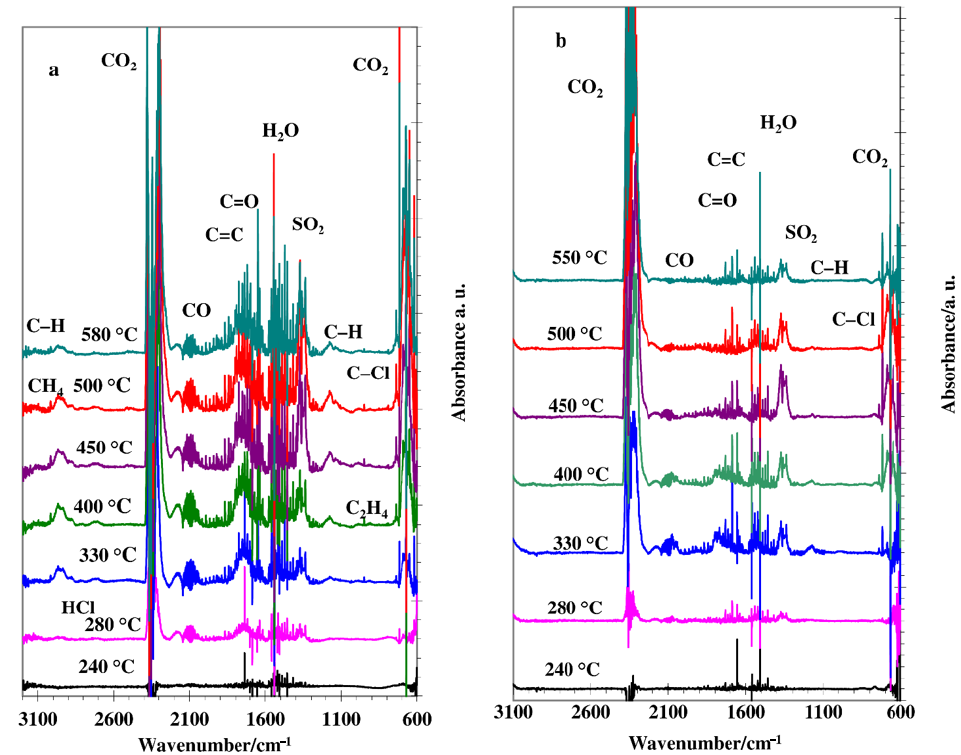
time between organic gaseous compounds formed at thermooxidative decomposition and oxygen unable for complete oxidation of these species before leaving the furnace [16]. Figure 3. FTIR spectra of gaseous compounds at heating rate of 10 ◦ C min − 1 : ( a ) EOSI, ( b ) MOS.